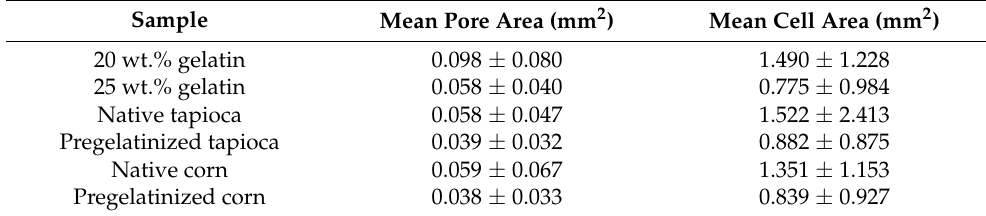
Table 6. Mean pore and cell areas of the foams with different